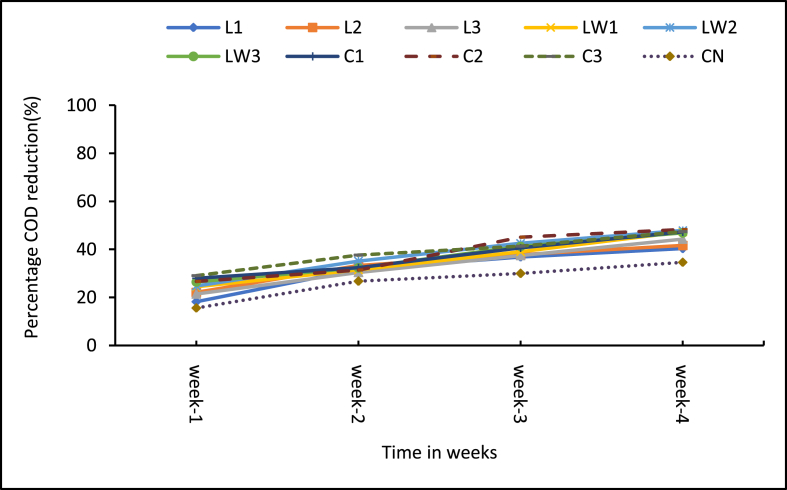
Cumulative mean reduction in COD levels. Note: L1 = 25 mL stock LSEC, L2 = 50 mL stock LSEC, L3 = 75 mL stock LSEC, LW1 = 0.1% DF, LW2 = 0.5% DF, LW3 = 1% DF, C1 = 5 g calcium carbide, C2 = 8 g calcium carbide, C3 = 10 g calcium carbide, CN = control.